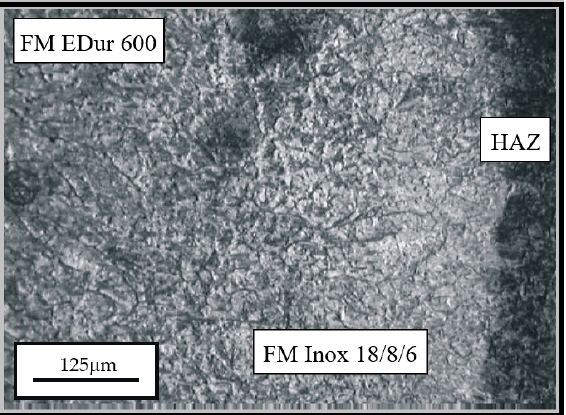
Figure 4. Appearance of microstructure of the hard-faced sample obtained by the two filler metals combination: FM EDur 600—left, FM Inox 18/8/6—middle; HAZ—right.